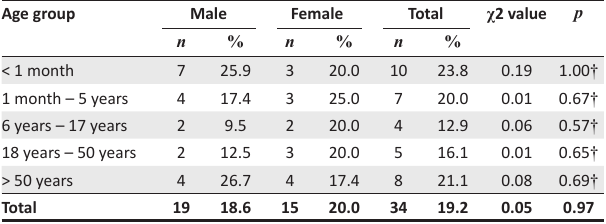
TABLE 2: Frequency of culture-positive broths by age group among bloodstream infection cases at the Federal Teaching Hospital, Ido-Ekiti, Nigeria, between